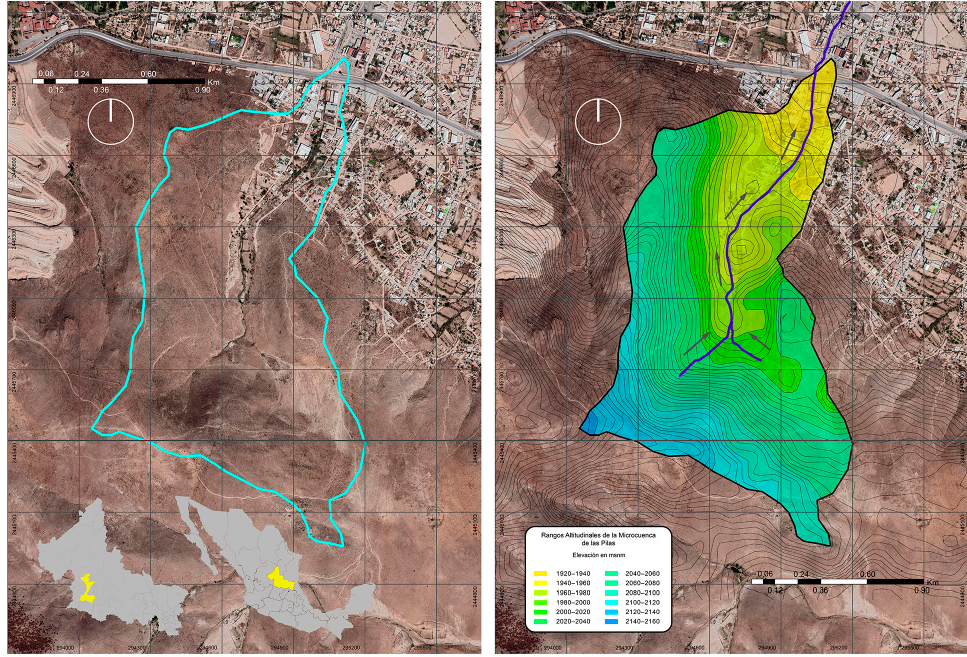
Figure 1. Geographical location, delimitation of Las Pilas micro-watershed in relation to urban growth from north and west sides.